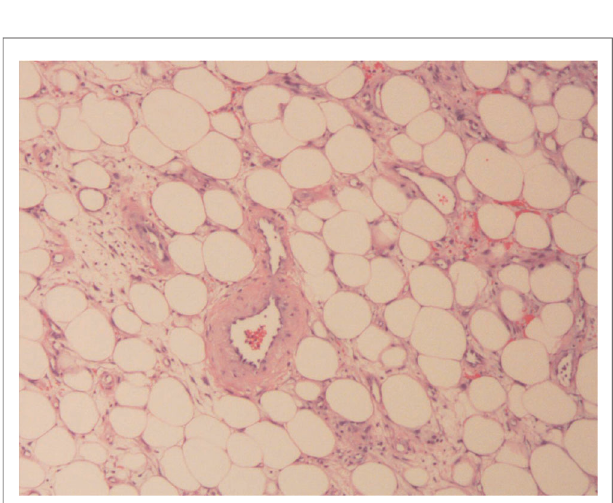
FIGURE 4 | Postoperative pathology suggesting localized adipose tissue neoplastic hyperplasia in the intestinal wall, consistent with a lipoma